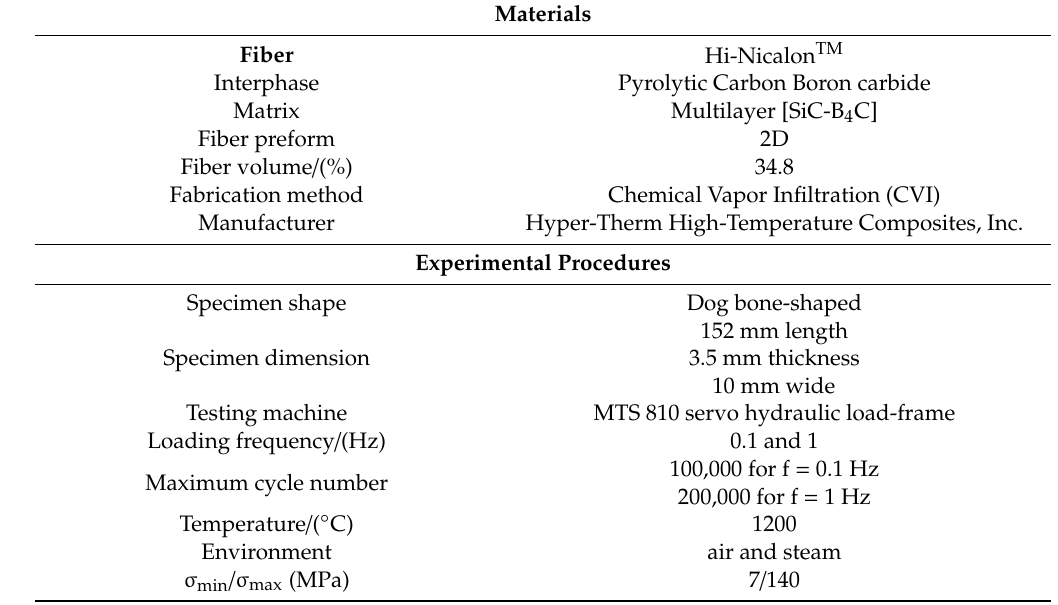
Table 2. Materials and experimental procedures of 2D woven Hi-Nicalon TM SiC / [SiC-B 4 C] composite at 1200 ◦ C in air and steam